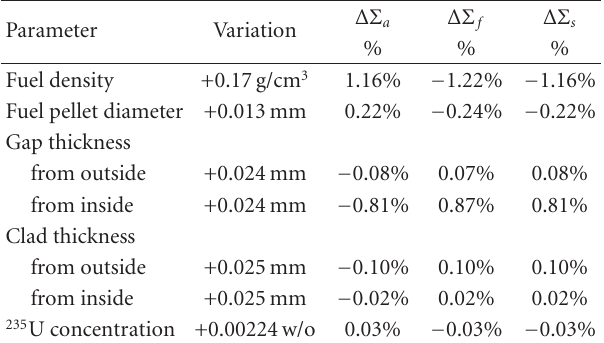
Table 9: Manufacturing sensitivities on macroscopic cross-sections for TMI-1 fuel pin